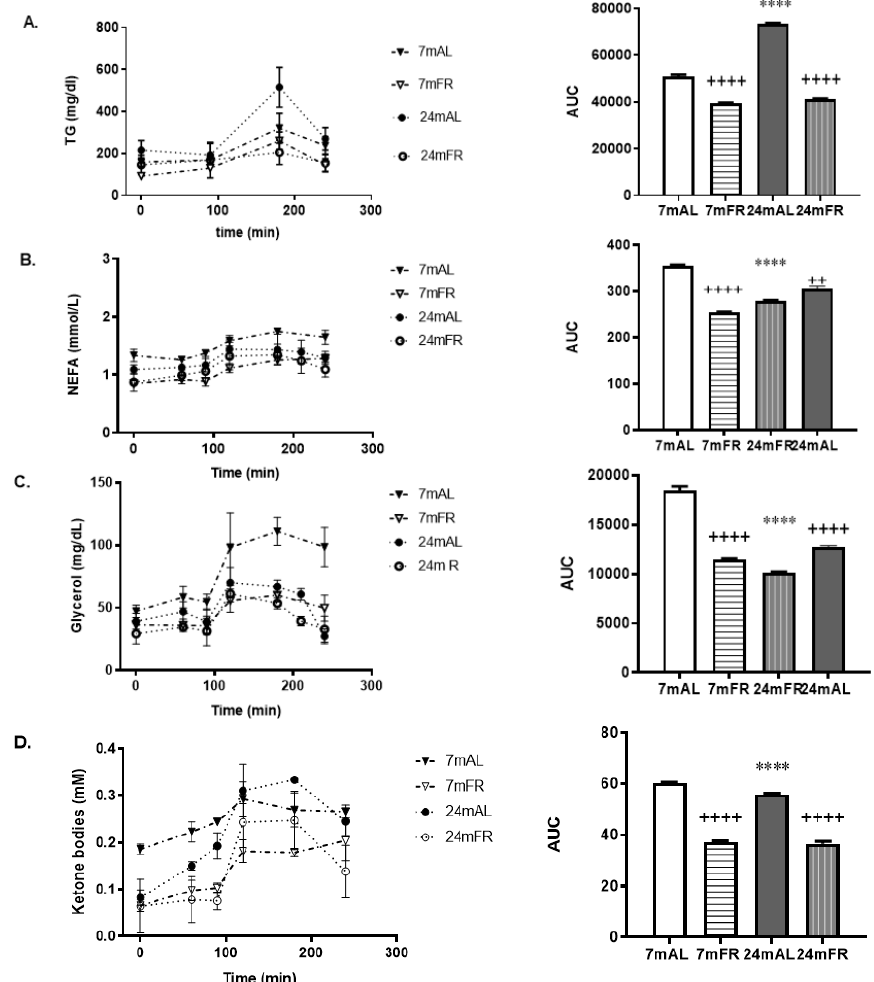
Figure 2. Evolution of serum triacylglycerol ( A ), nonesterified fatty acid (NEFA) ( B ), glycerol ( C ), and ketone body ( D ) levels in 7- and 24-month-old rats fed ad libitum (AL) or food restricted (FR), after an oral lipid loading test (OLLT). Blood aliquots from the tail vein were taken at 0, 30, 60, 90, 120, 180, and 240 min after the OLLT. Serum samples obtained by blood centrifugation at each time were pooled and used for the measurement of hormones and metabolites, conducted in duplicates. Results are the mean ± SEM of 8–10 rats per group. Overall changes in TG, NEFA, Glycerol, and ketone body levels during the oral lipid loading test were calculated as the area under the curve (AUC) above the basal level. Unpaired Student’s t -test, **** p ≤ 0.0001 compared to 7-month-old rats under the same feeding protocol; ++ p ≤ 0.0025, ++++ p ≤ 0.0001 compared to age-matched ad libitum fed